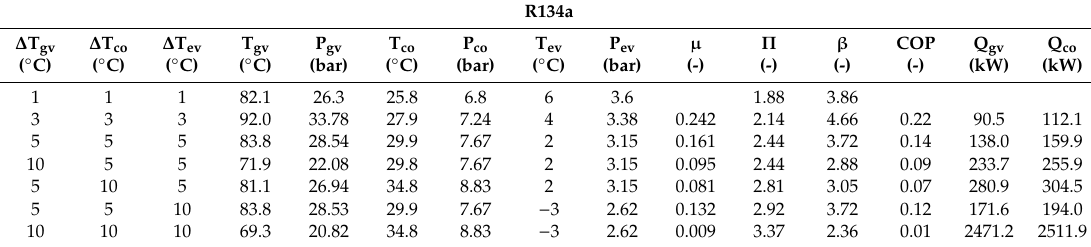
Table A5. Thermodynamic analysis results for R134a.